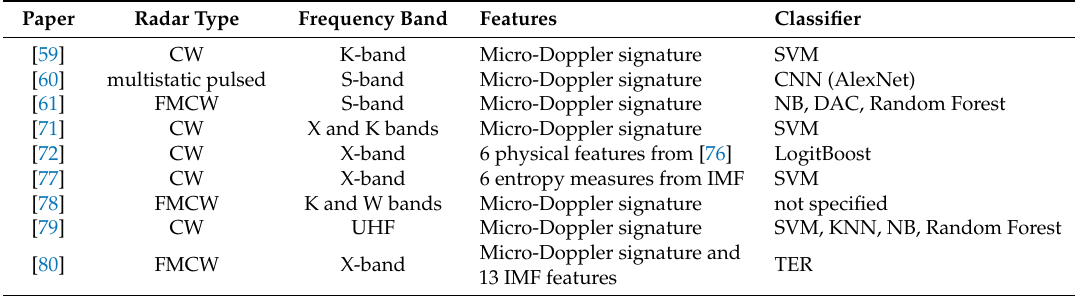
Table 4. Type of radar, operating frequency, features and specific classifiers used in the reviewed drone classification